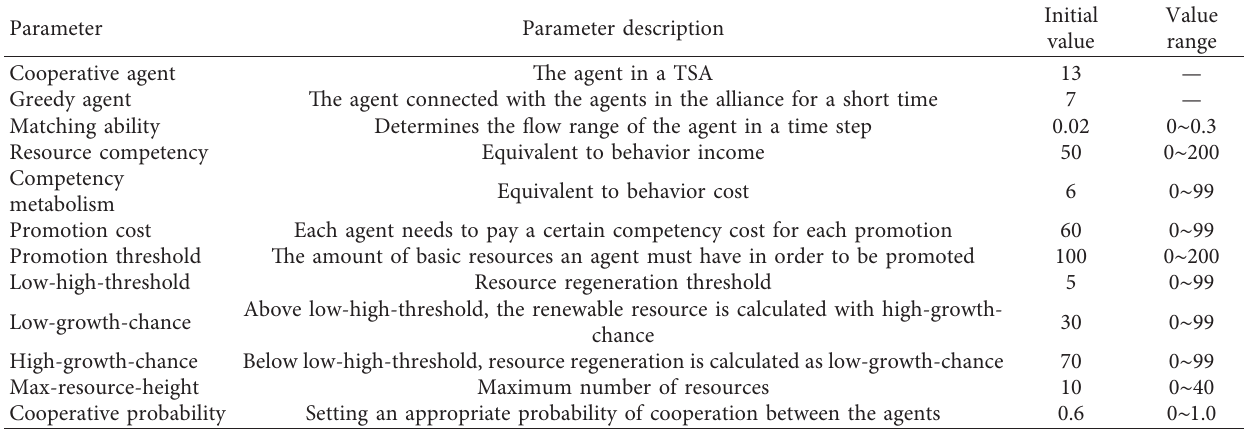
Table 1: Simulation parameter setting.